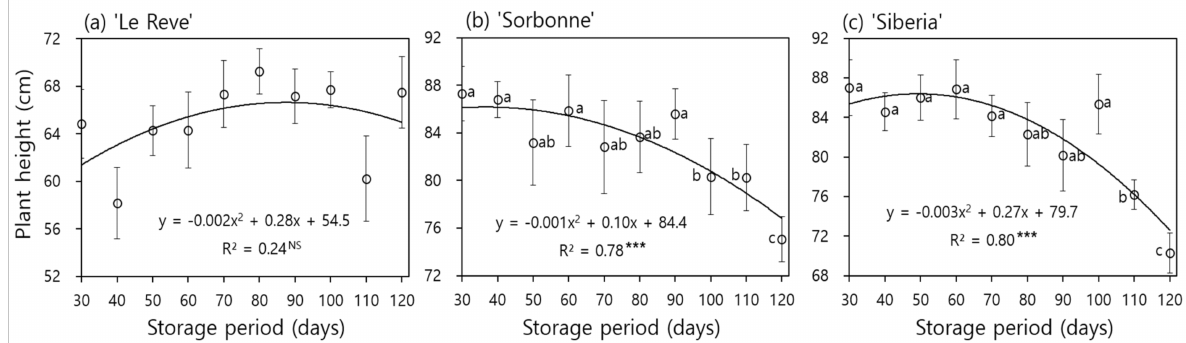
Figure 3. Plant height at the harvest of cut flowers as influenced by bulb storage period at 0 ◦ C in Lilium Oriental Hybrids ‘Le Reve’ ( a ), ‘Sorbonne’ ( b ), and ‘Siberia’ ( c ). Within-graph means followed by the same letter are not significantly different by Tukey’s honestly significant difference test at p ≤ 0.05. NS, *** Non-significant or significant at p < 0.001, respectively.